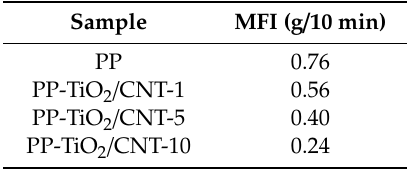
Table 2. Flow index of the samples